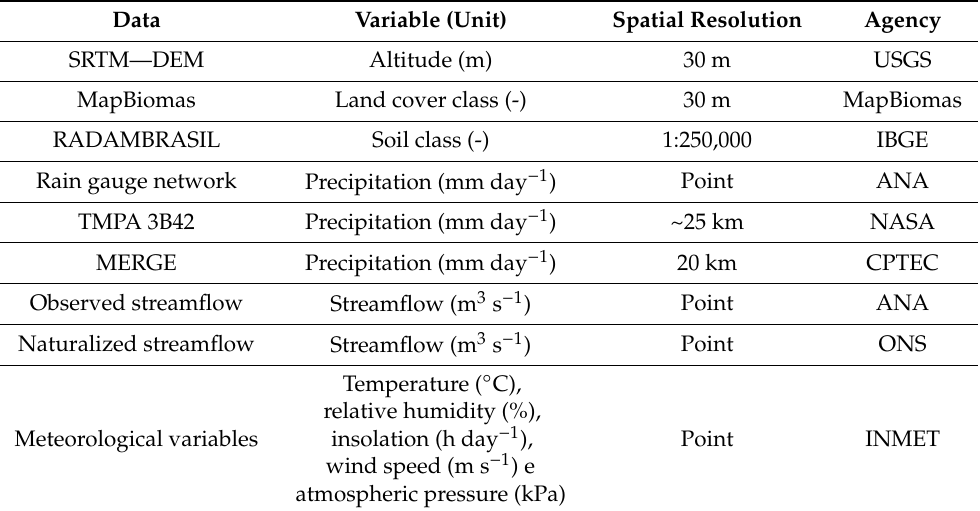
Table 1. Model input